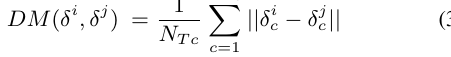
Figure 3: Probability of a laser point belonging to a vertical plane.